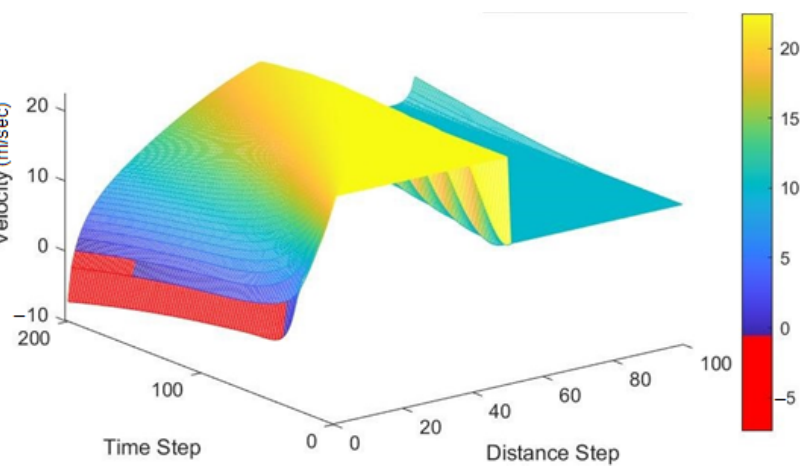
Figure 11. Density behavior of proposed model on straight road with no ingress traffic.